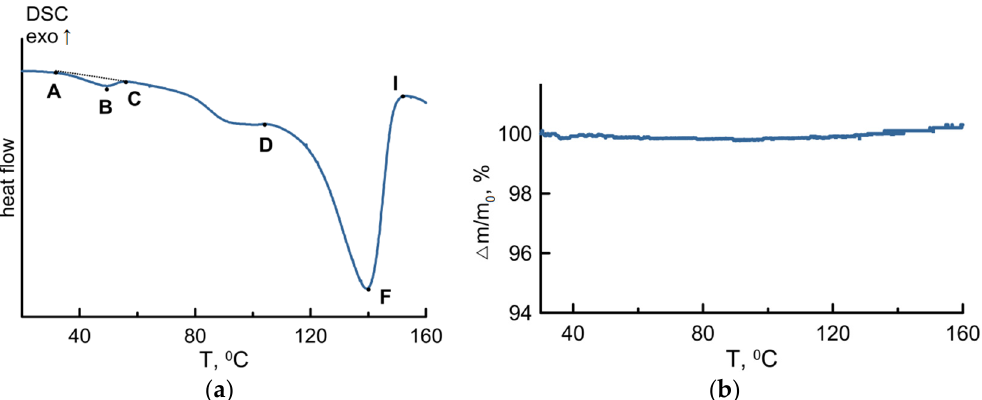
Figure 1. Differential scanning calorimetry (DSC) ( a ) and thermogravimetric (TG) ( b ) measurements of Cd(C 12 H 25 S) 2 powder in an argon atmosphere.